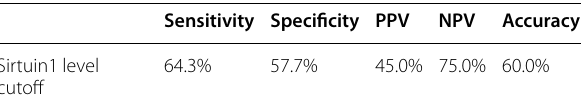
Table 7 Validity of sirtuin1 in prediction of patients with AMI or unstable angina